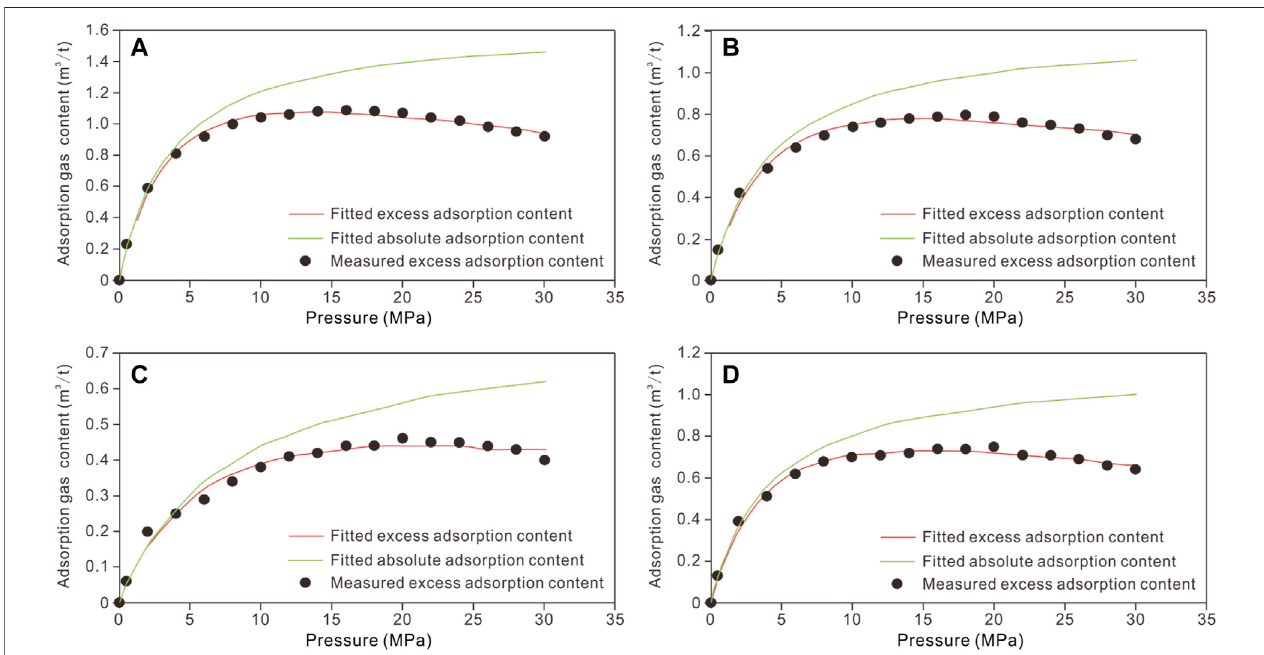
FIGURE 8 | Methane isothermal adsorption results for the Upper Permian Linghao Formation shale/mudstone from the studied well in Nanpanjiang Basin. (A) Organic-richshale,Ling1member,3,767.54 m. (B) Organic-richshale,Ling1member,3,772.24 m. (C) Mudstone,Ling2member,3,557.75 m. (D) Organic-richshale, Ling 3 member, 3,412.12